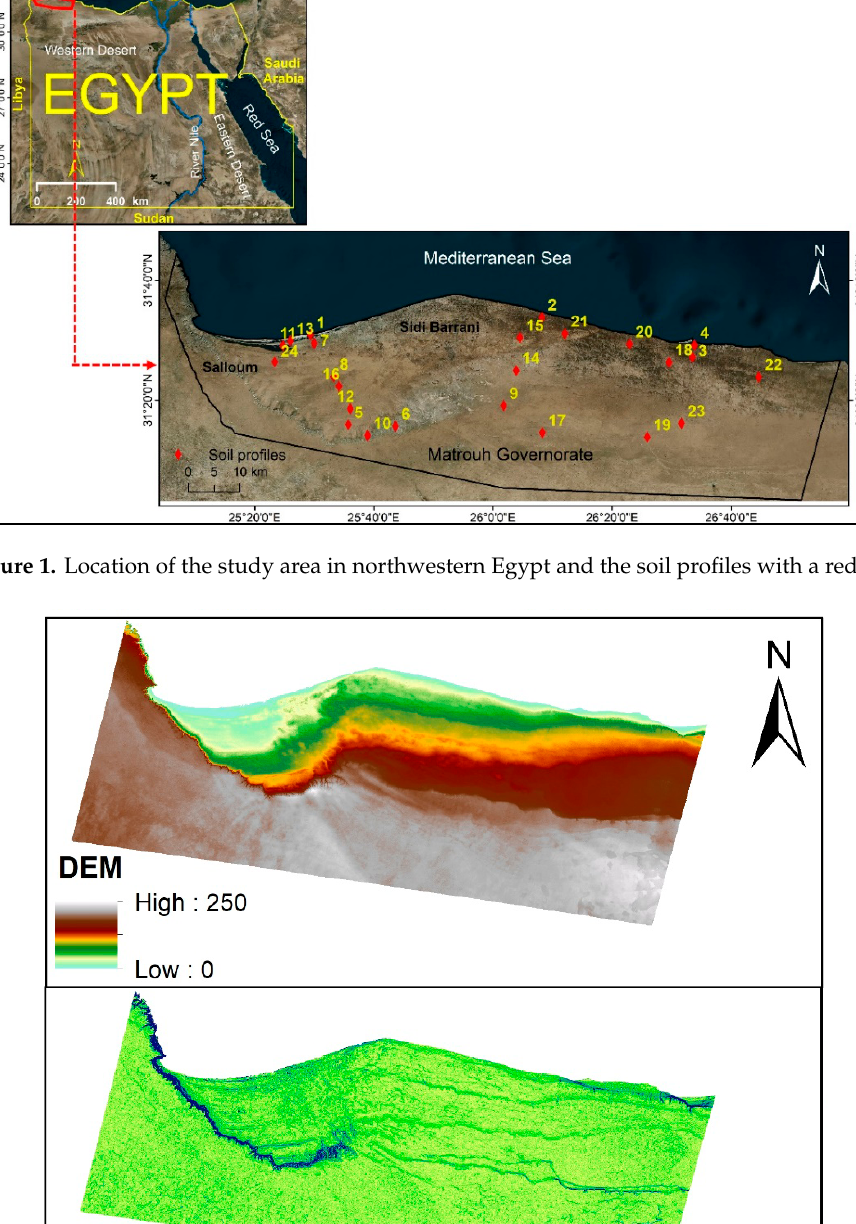
Figure 1. Location of the study area in northwestern Egypt and the soil profiles with a red dot.